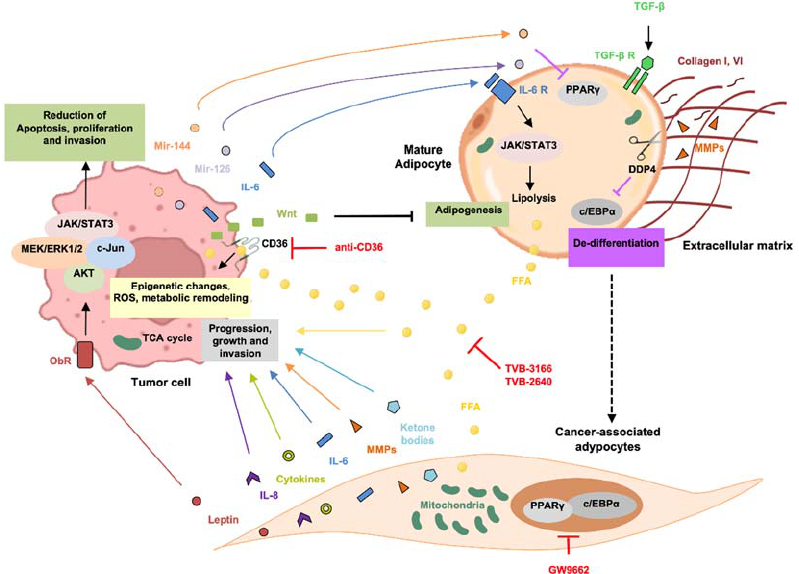
Figure 1. Schematic diagram showing the direct crosstalk between tumor cells, mature adipocytes, the cancer ‐ associated adipocyte (CAA) phenotype, and possible targeting therapeutic strategies. Drugs targeting the biological mediators of adipose tissue–tumor bidirectional crosstalk are shown in red. CAAs can be distinguished from mature adipocytes according to their morphology and phenotype during the dedifferentiation process. The fibroblast ‐ like morphology, typ ‐ ical of CAAs, is due to de ‐ lipidation and alteration of the fat storage capacity, as found in patients with colorectal cancer [53]. In addition, compared to mature adipocytes, CAAs are smaller, have an increased number of mitochondria, show lower expression of differ ‐ entiation markers, and exhibit a proinflammatory phenotype [3]. Among the adipokines secreted by CAAs, leptin, matrix metalloproteinase (MMP) ‐ 11, CCL2, chemokine ligand 5 (CCL5), IL ‐ 6, IL ‐ 1 β , and TNF ‐α have been identified (Figure 1) [57–59]. These reactive adipocytes not only contribute to energy storage, thanks to the uptake of lipids, such as triacylglycerols (TAGs), which can be released in the microenvironment in the form of free fatty acids (FFAs), but also represent a source of a plethora of factors that induce both local and systemic effects [60]. CAAs adopt a dedifferentiation phenotype following tight crosstalk with CSCs. In particular, the expression of peroxisome proliferator ‐ activated receptor γ (PPAR γ ) and CCAAT/enhancer ‐ binding protein β (c/EBP α ) is markedly inhibited, with a subsequent reduction in the mRNA levels of two markers of mature adipocytes, such as fatty ‐ acid ‐ binding protein 4 (FABP4) and hormone ‐ sensitive lipase (HSL) [61,62]. The decrease in lipid droplets and cell size leads to the release of FFAs and ketone bodies, crucial factors for CSC metabolism in the promotion of tumor progression [59]. Another distinctive trait of CAAs is the increased production of ECM ‐ related molecules, such as MMP ‐ 11, PAI ‐ 1, MMP1, fibroblast ‐ activating protein (FAP), and collagen VI, which are involved in ECM remodeling, thus representing a crucial step in tumor progression [63]. In CAAs, the pro ‐ duction and release of leptin and resistin is increased while the expression of adiponectin and adipokines with antitumorigenic functions is reduced [55]. 4.1. Mechanisms and Regulation of CAA Activation